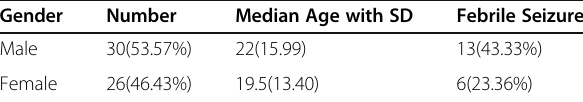
Table 1 Age, gender, and presence of febrile seizures in patients with complex partial seizure (focal onset seizures with impaired